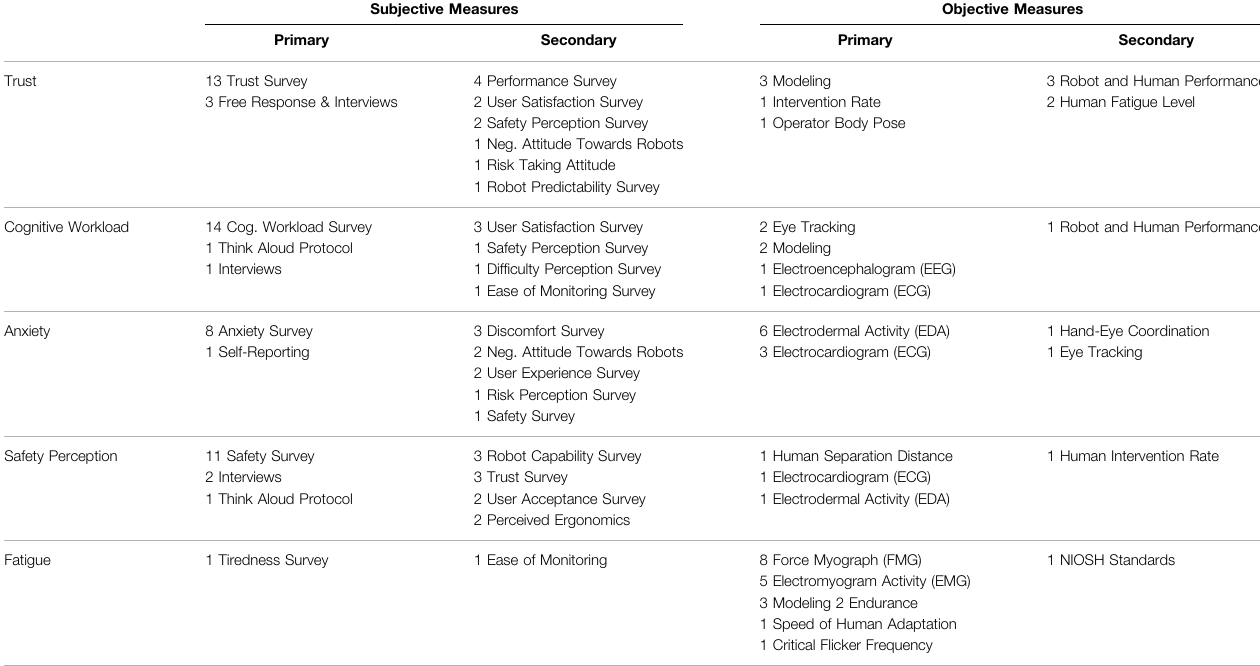
The top fi ve measured HFs, are represented above with corresponding # column representing how many papers use this